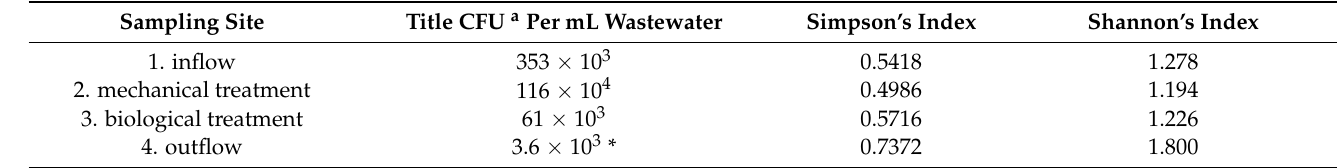
Table 1. Abundance and biodiversity of cultivable heterotrophic bacterial community in wa- ter samples from different stages during the wastewater treatment process in Kokšov-Bakša, Košice